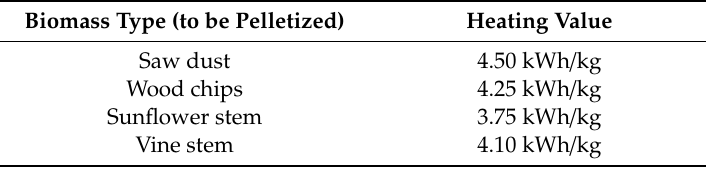
Table 6. Biomass types that must be pelletized before usage.